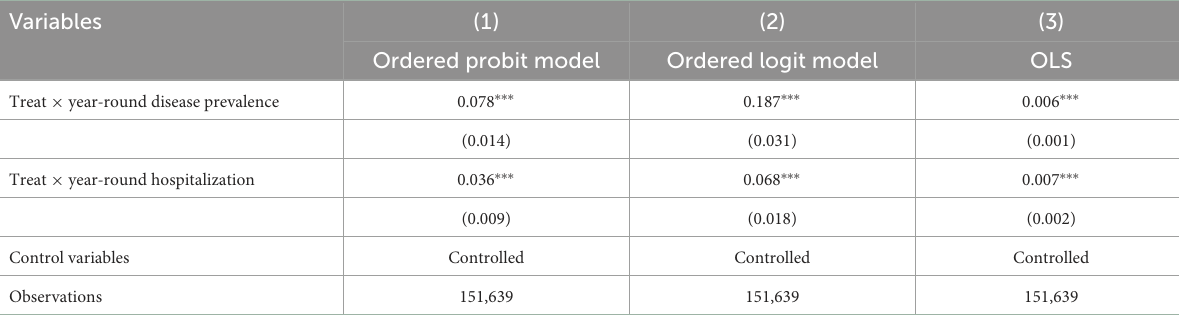
TABLE 6 Robustness test: replacement of dependent